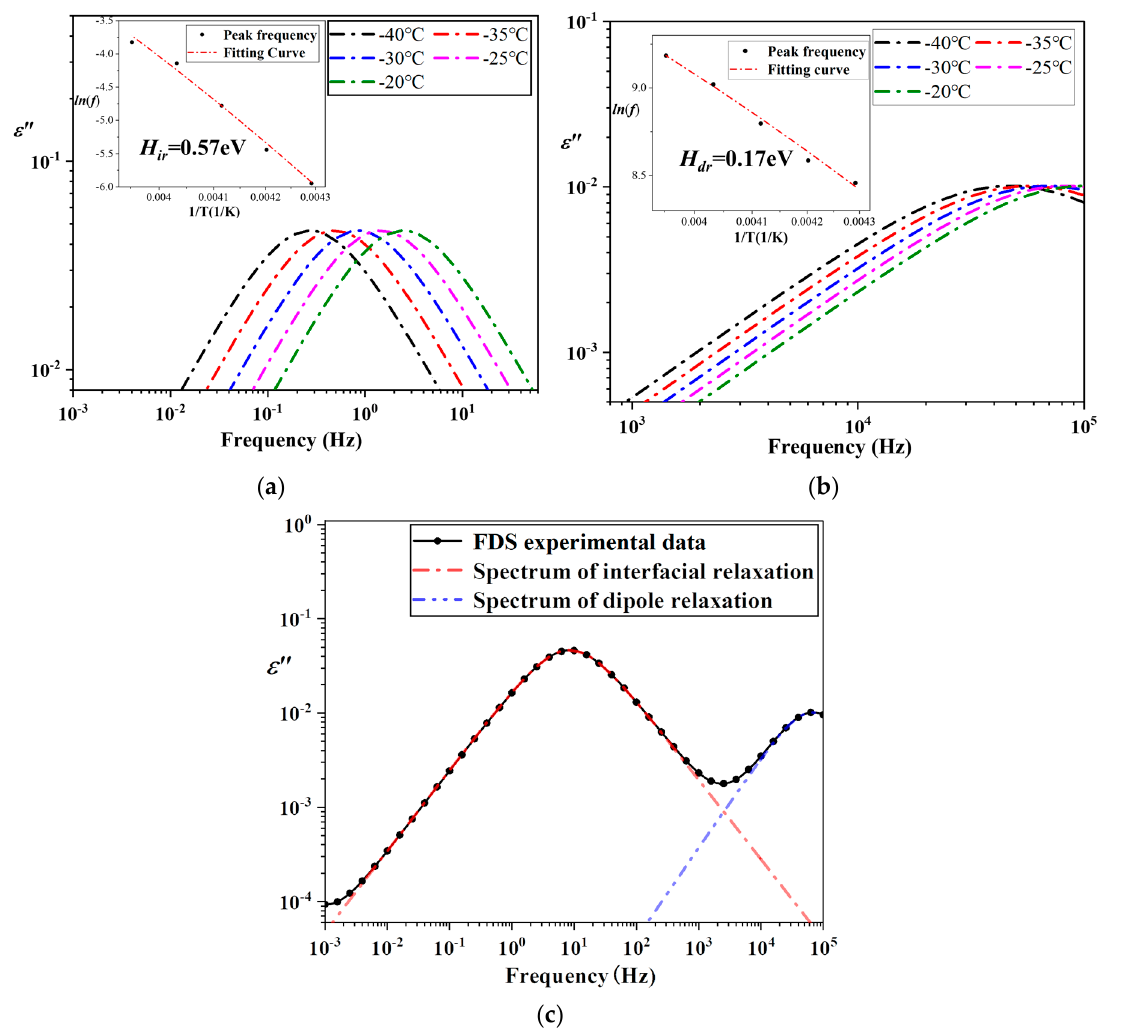
Figure 13. Data analysis for FDS tested in the low-temperature range. ( a ) Independent spectra for interfacial relaxation in the low-temperature range. ( b ) Independent spectra for dipole relaxation in the low-temperature range. ( c ) Physical model of FDS tested in the low-temperature range.